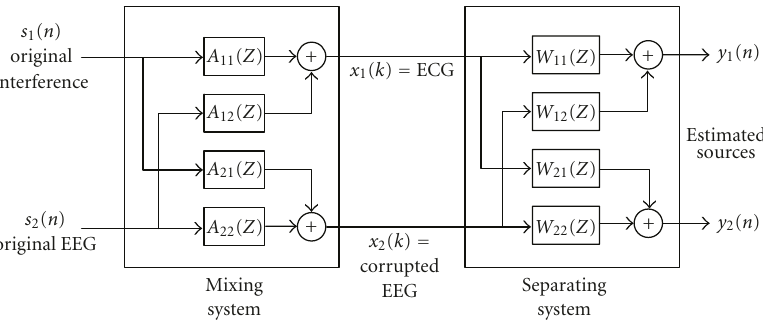
Figure 9: Convolutive linear mixture of two sources and the corresponding source separation system.